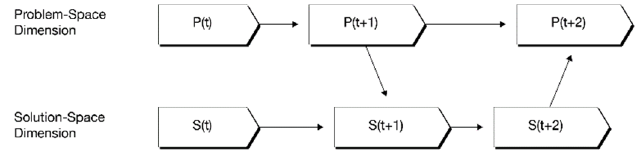
Figure 4. Process of co-evolution of problem-solution adapted from [25]. P(t) and S(t) are interactive.